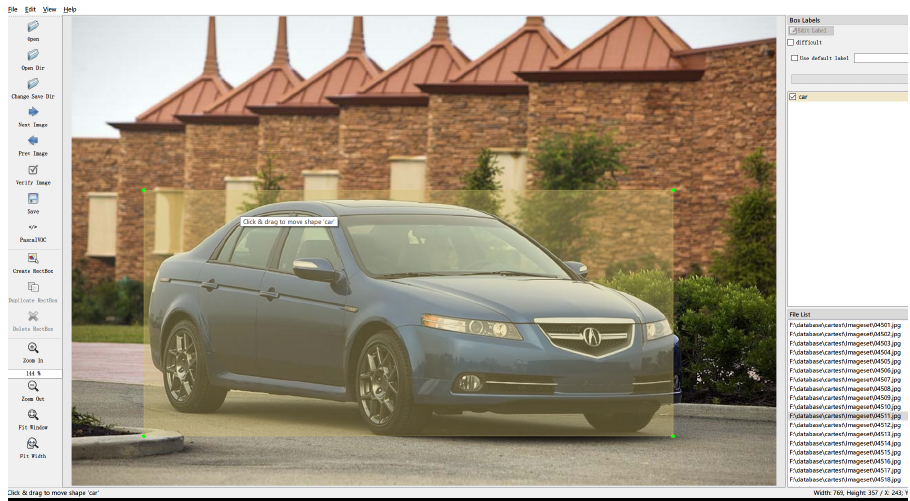
Figure 1. Portioned images extracted from the dataset.